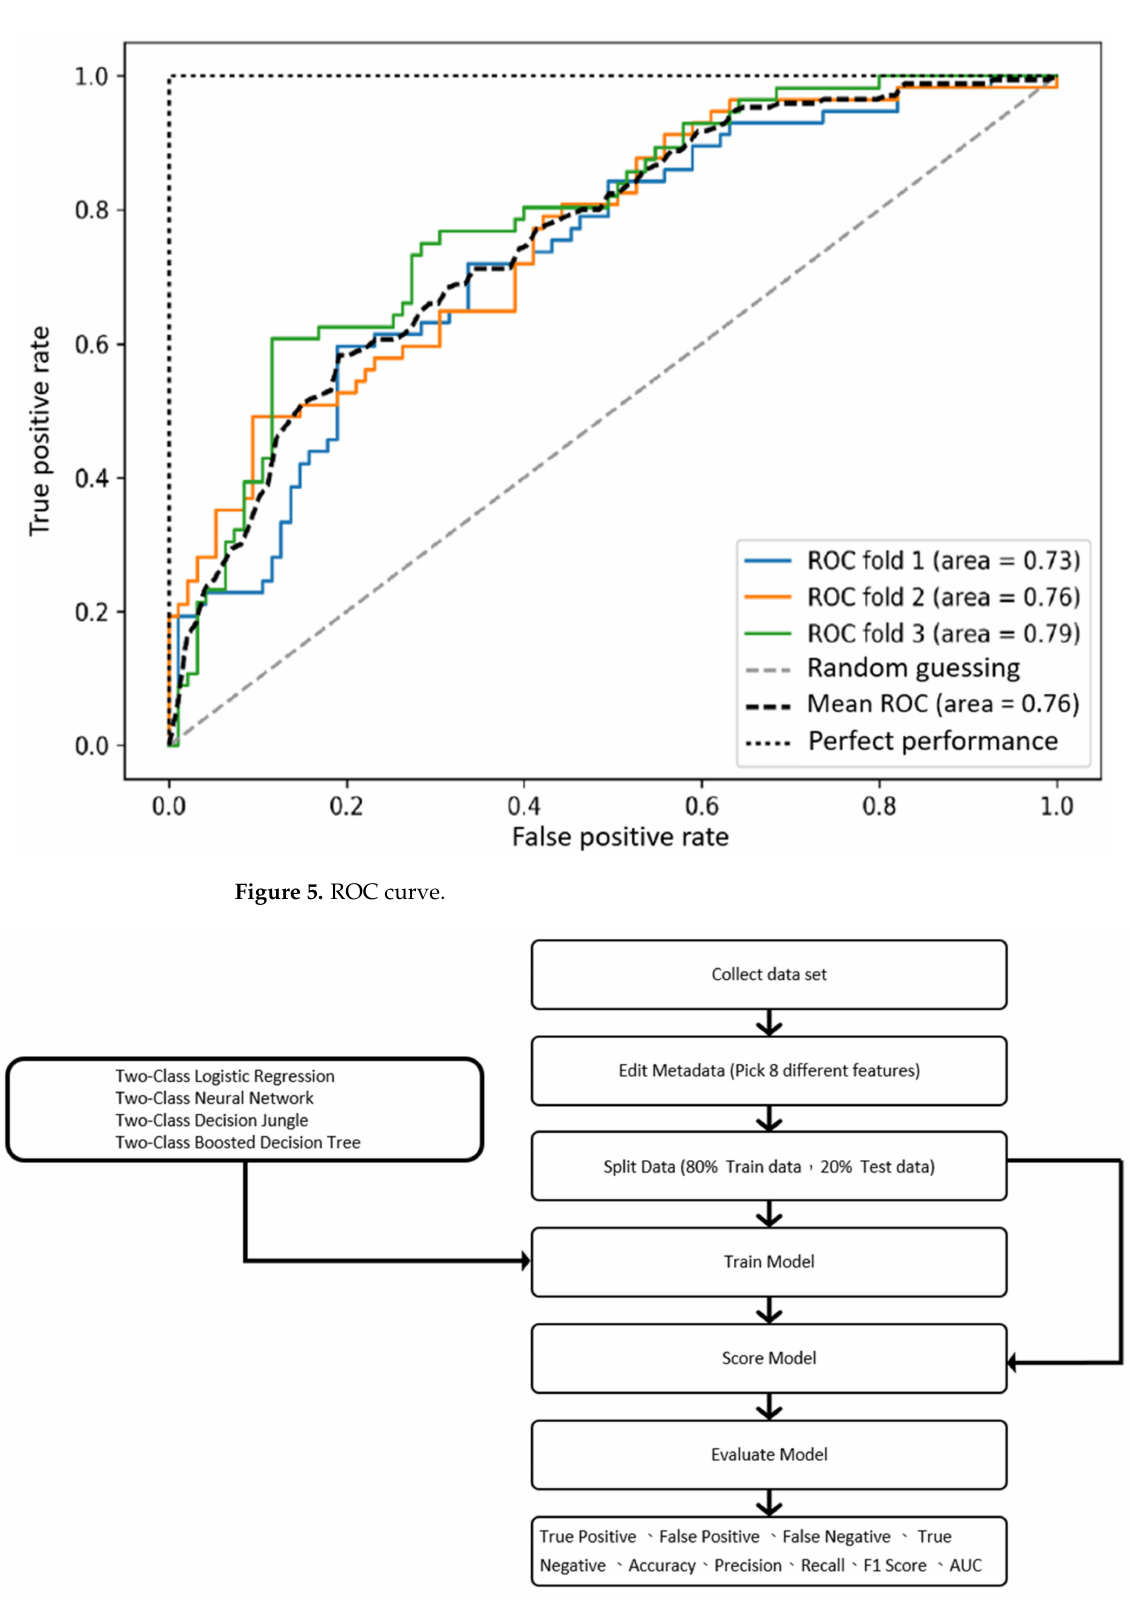
Figure 6. The study flow